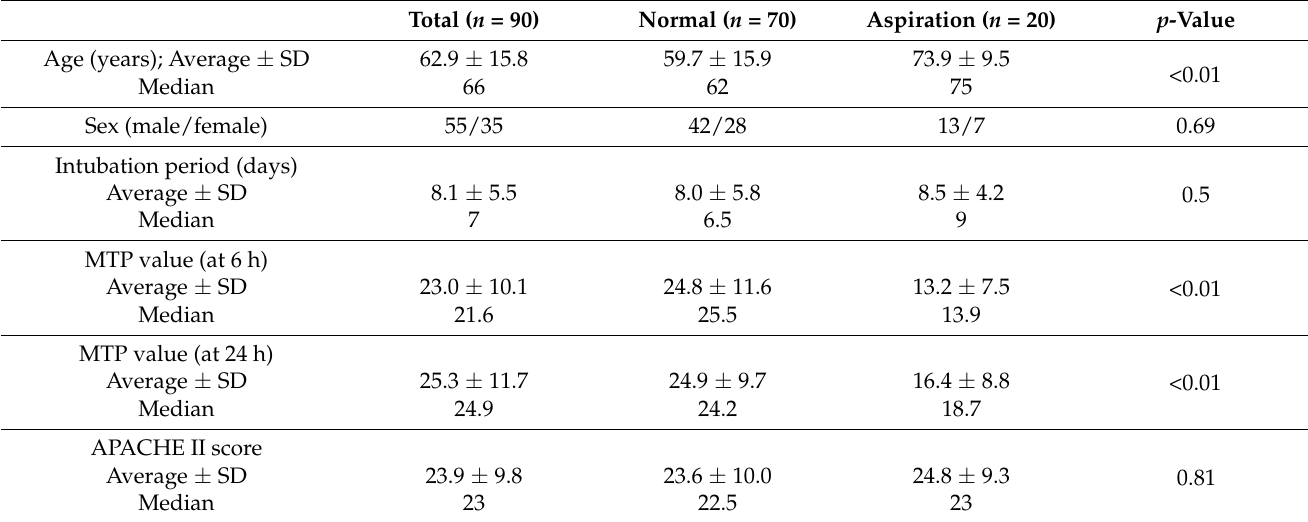
Table 1. Background characteristics of the patients in the normal and aspiration groups.